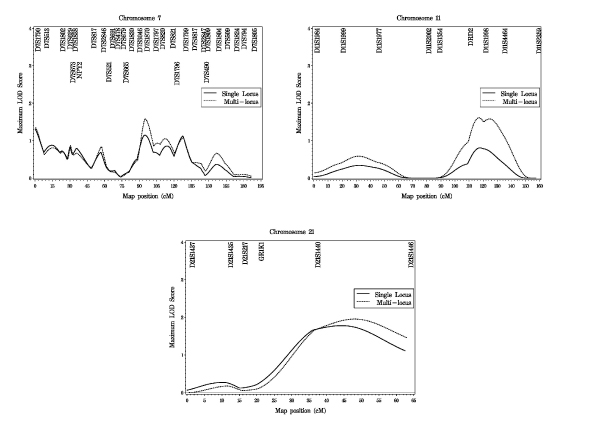
NPL single-locus and multiple locus regression.